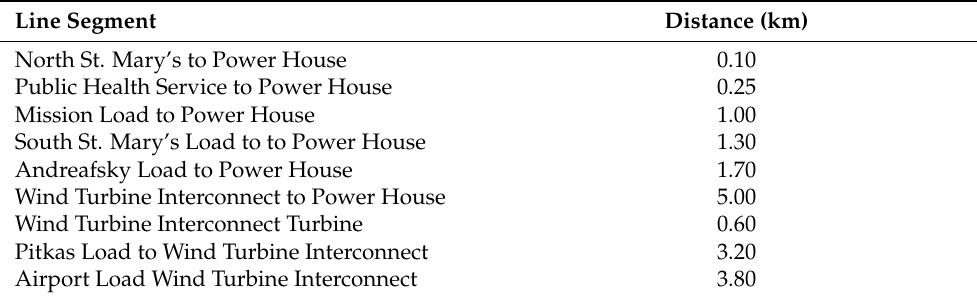
Table 2. Lengths of the Transmission Lines for the St. Mary’s